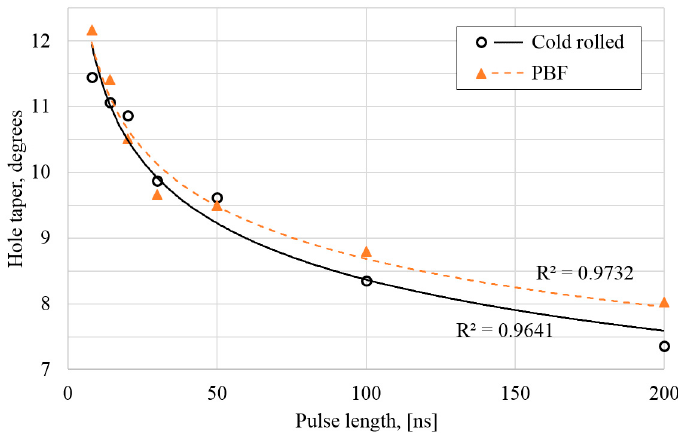
Figure 9. Measured hole tapers in degrees for all the drilled holes.